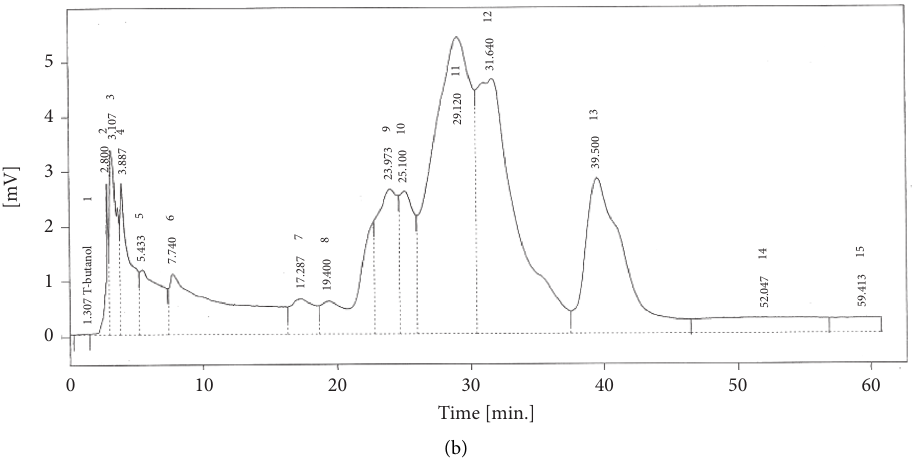
Figure 3: HPLC chromatograms of (M) charantia (L) leaves for phenolic profile. (a) Control, (b) zinc sulfate priming.